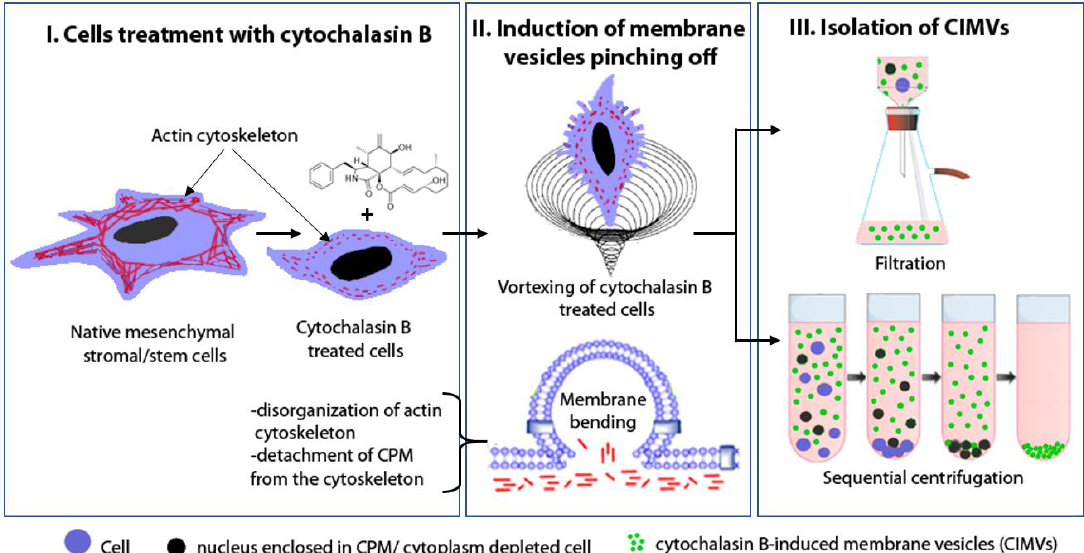
Figure 1. The scheme of cytochalasin B-induced membrane vesicles (CIMVs) production.